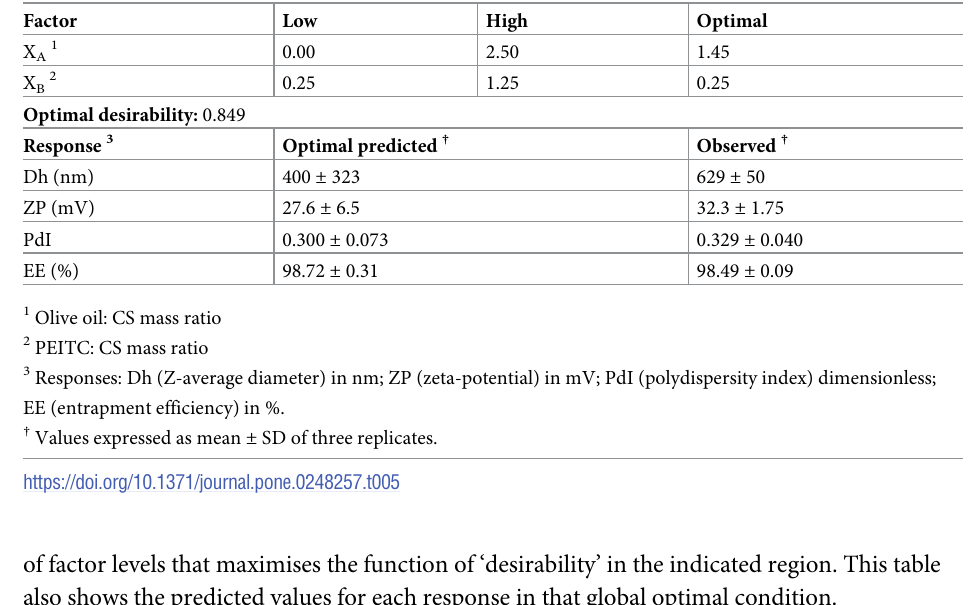
Table 5. Derringer optimisation of polymeric MPs and